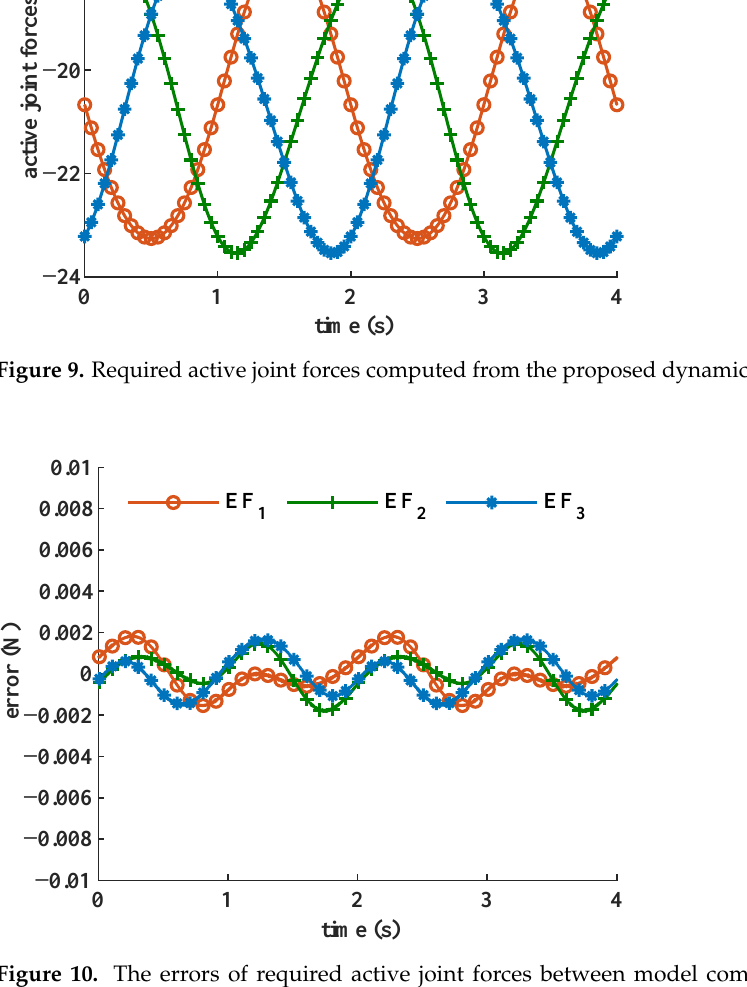
Figure 10. The errors of required active joint forces between model computation and software